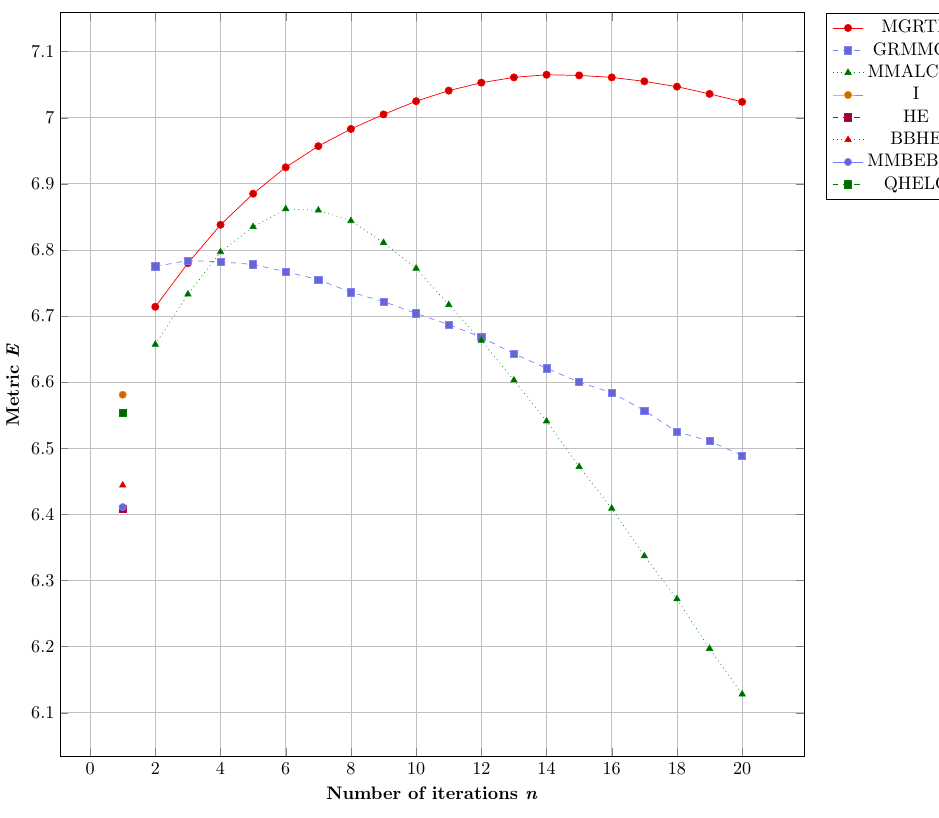
Figure 7. Comparison with respect to metric E.